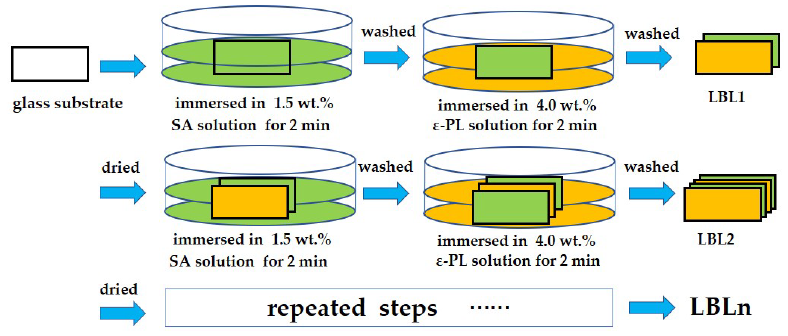
Figure 1. Schematics of film preparation.